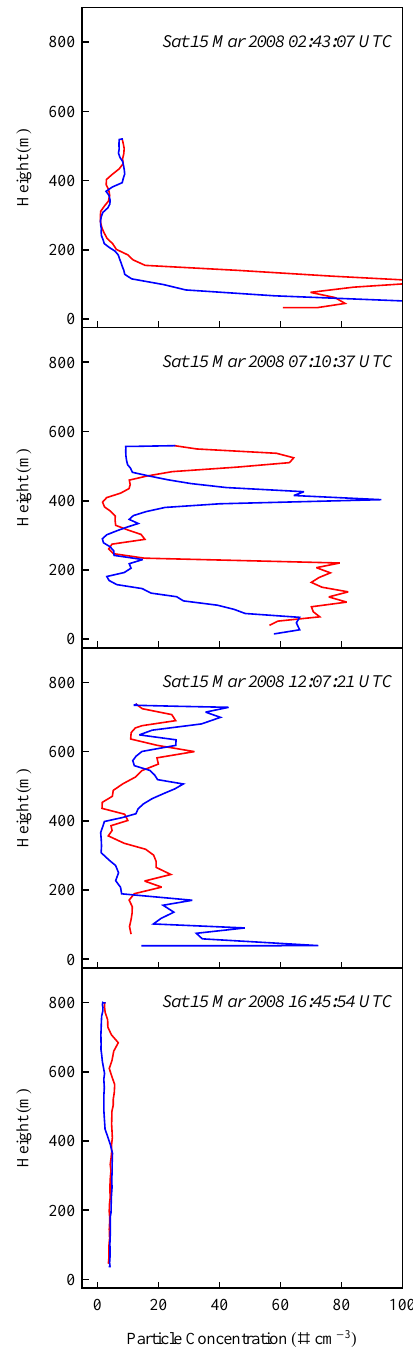
Fig. 10. Vertical profiles of total particle concentration from a four-channel optical particle counter (0.3µm, 0.5µm, 1µm, and 5µm) employed in balloon soundings at site K23 on 15 March 2008.